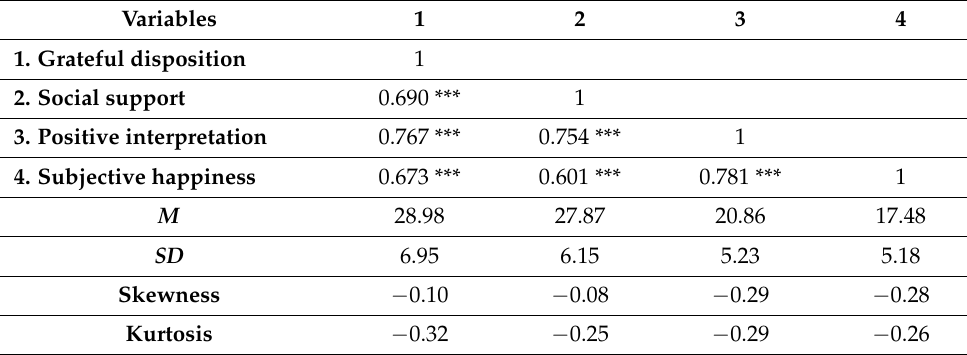
Table 2. Correlational matrix of grateful disposition, social support, positive interpretation, and subjective happiness in Korean young adults ( N =